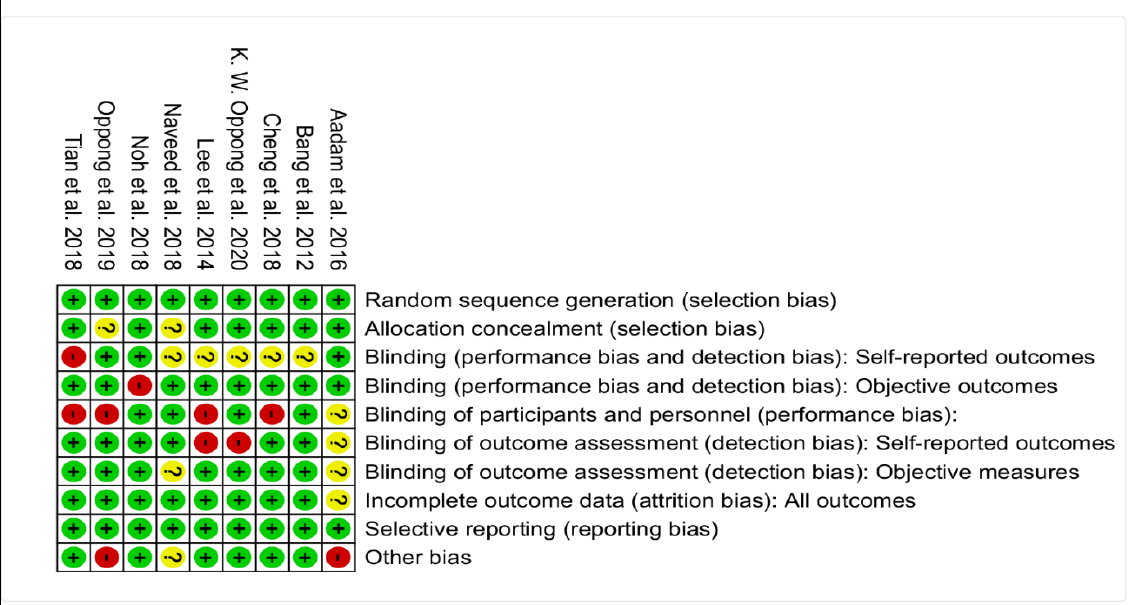
Figure 2. Evaluation of studies quality. Items evaluated as positive for the quality (in green); Negatively evaluated items (in red); The available information in the articles did not allow the evaluation for this item (in yellow) [13–21].